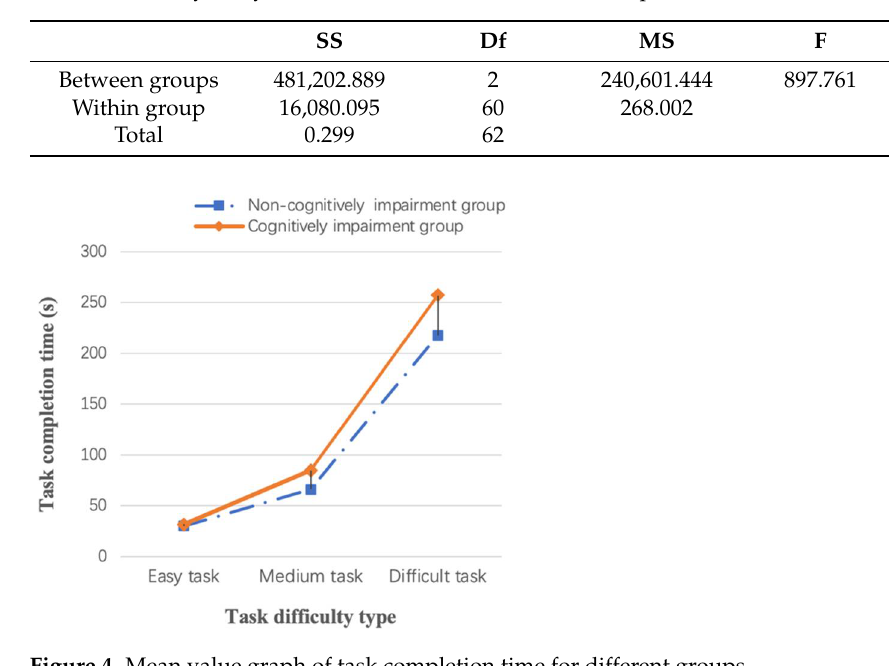
Table 3. One-way analysis of variance (ANOVA) for task completion time.